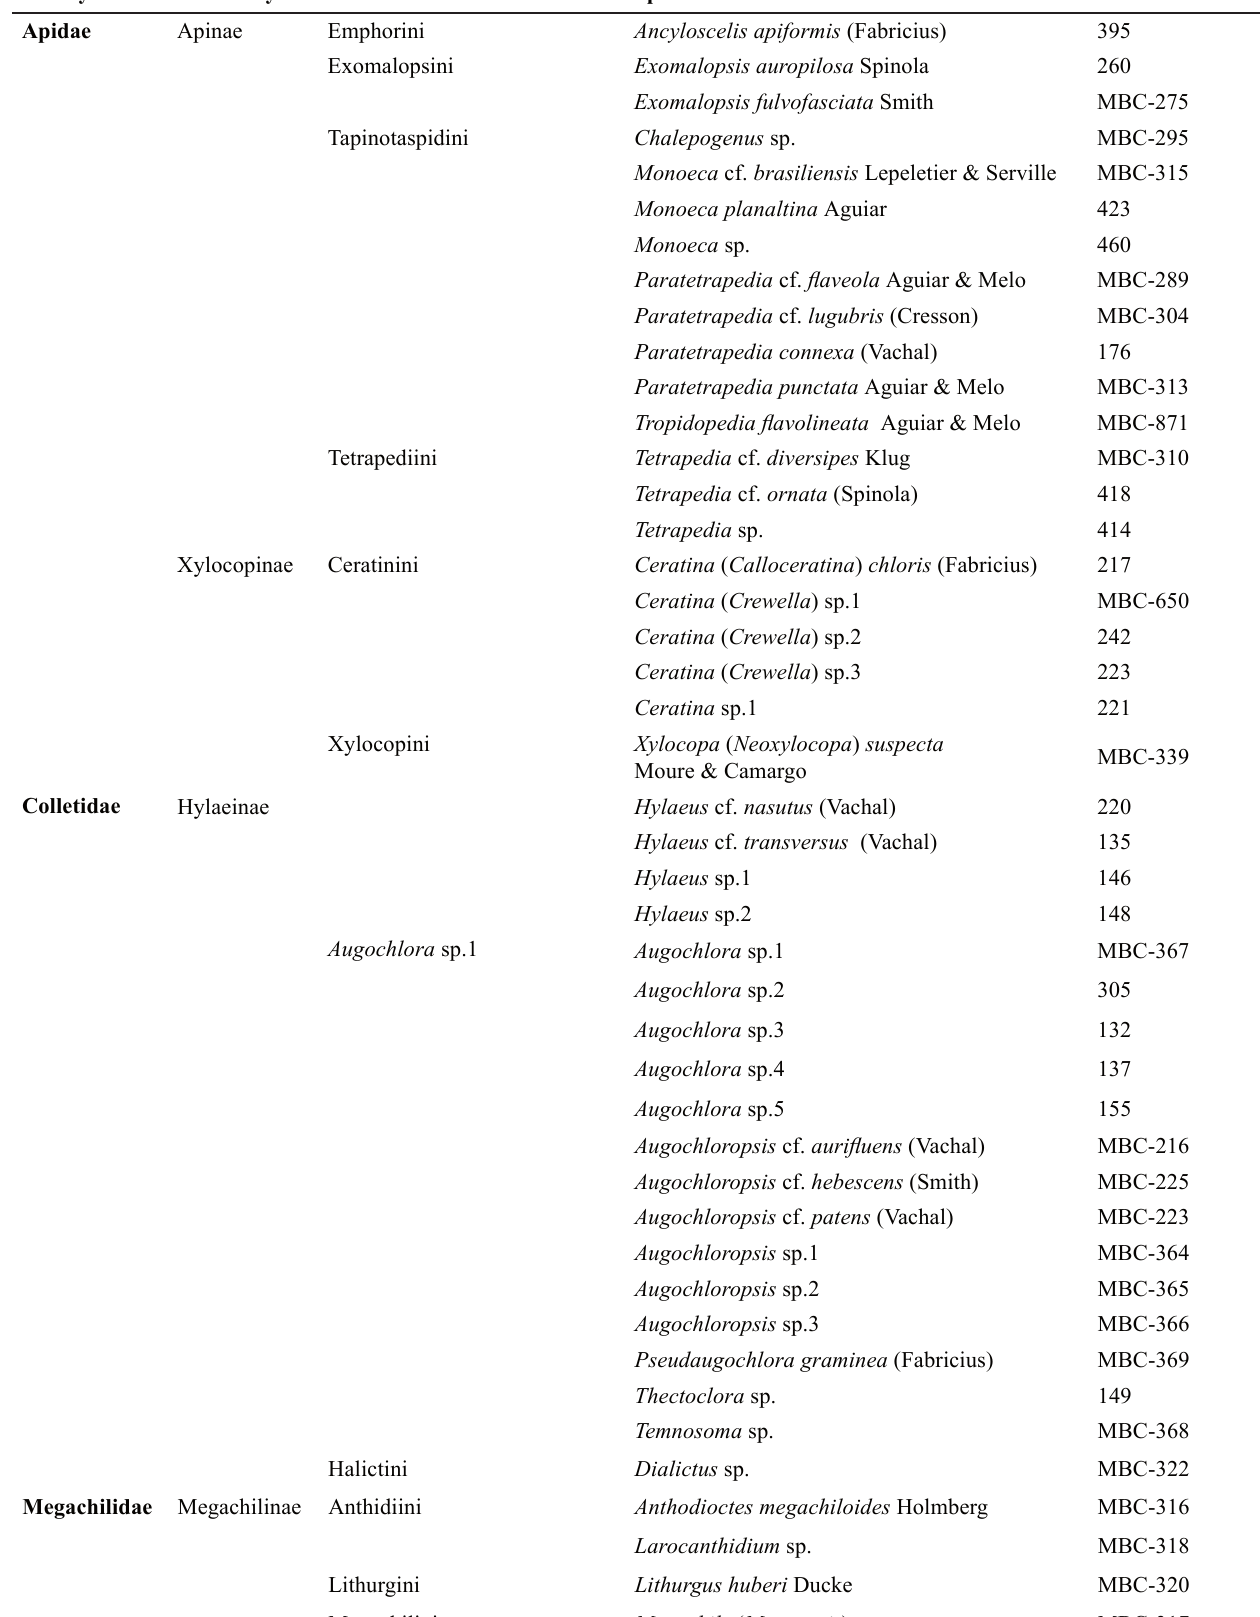
Table 1 . Bee species collected on the edge of the Semideciduous Forest of "Fazenda São José", Uberlândia-MG, in 2010 and 2011. Classification based on Silveira et al. (2002)